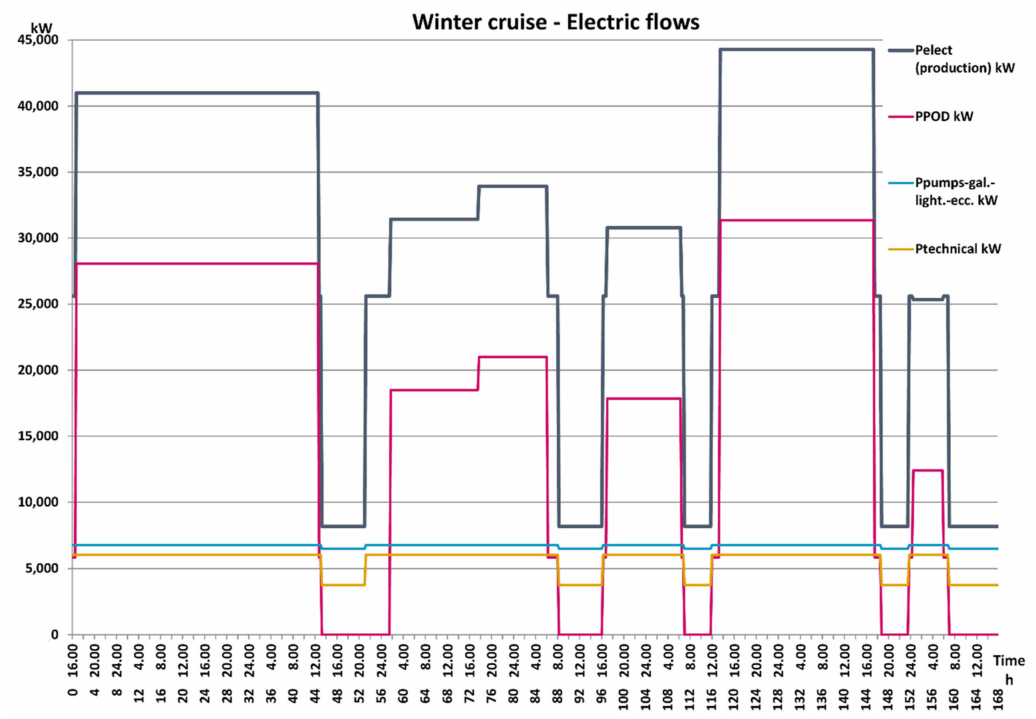
Figure 1. Electrical demand during the winter